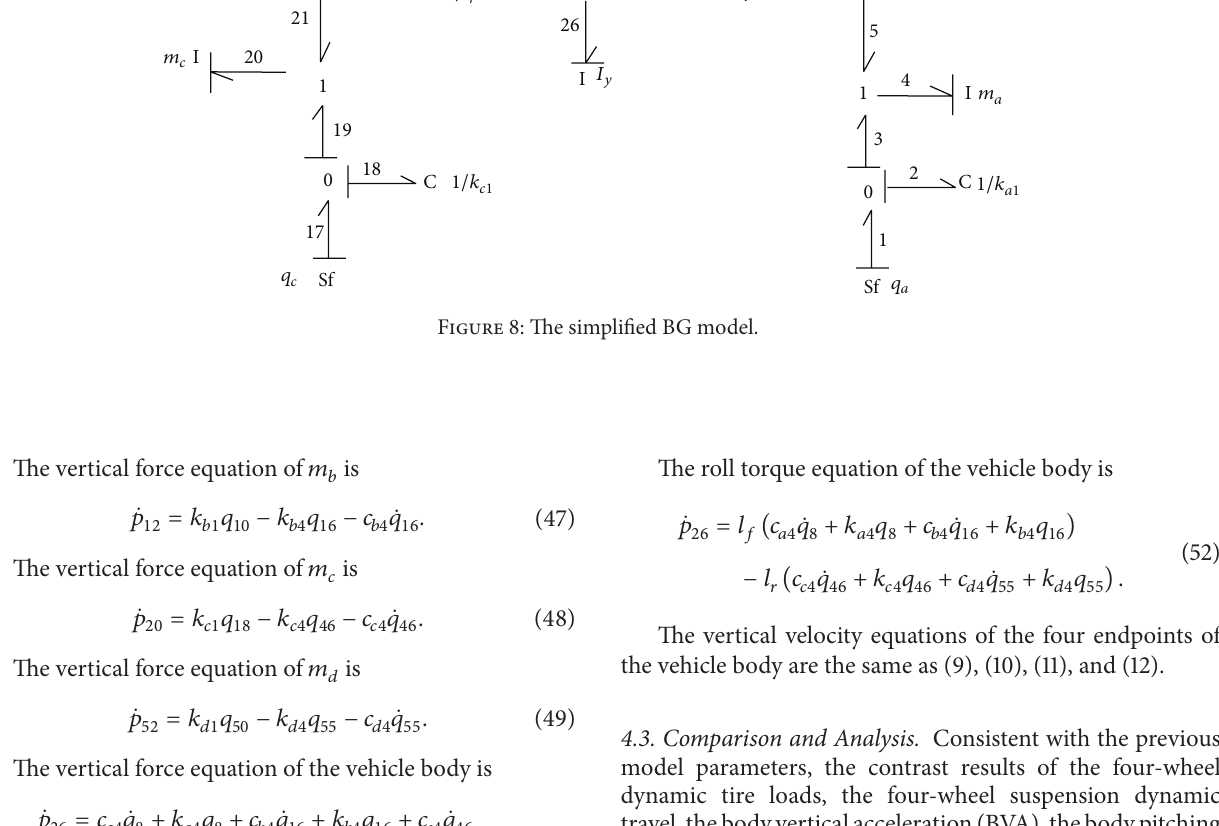
figures: the contrast results of the left front wheel tire dynamic load (LFWTDL), the right front wheel tire dynamic load (RFWTDL), the left rear wheel tire dynamic load (LRWTDL), and the right rear wheel tire dynamic load